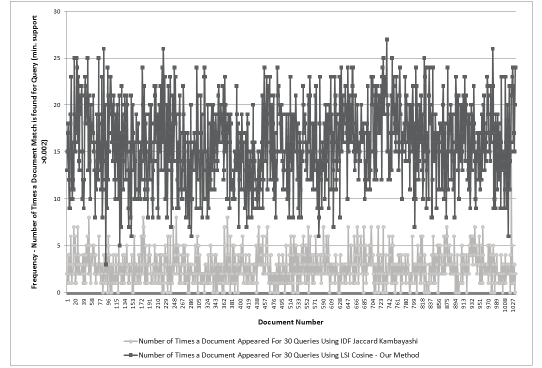
Fig. 12. Number of times a document appears for 30 queries Jac- card similarity vs. Cosine similarity